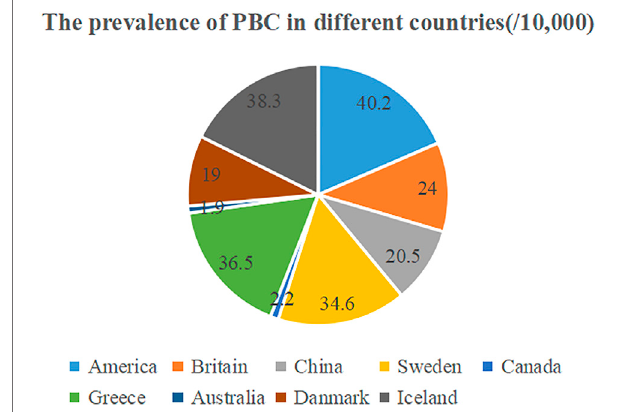
FIGURE 1 | The prevalence of PBC in different countries around the